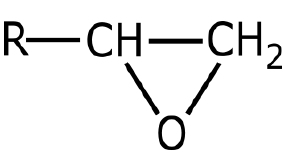
Figure 2. The epoxy or oxirane ring